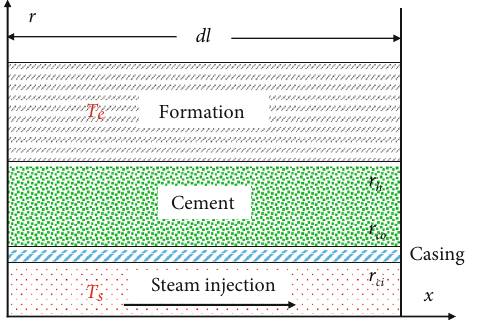
Figure 4: Schematic fi gure of heat transfer process between wellbore and formation.